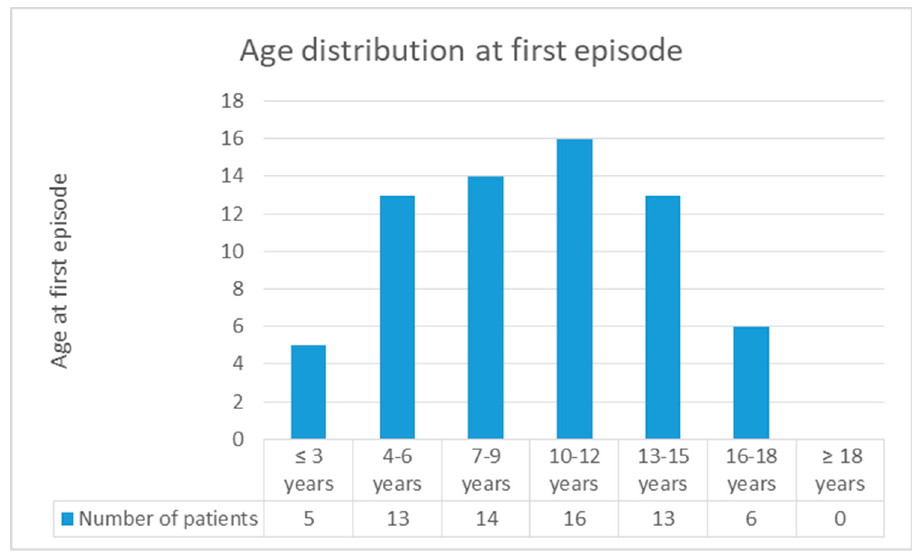
Figure 4. Age distribution at first episode.